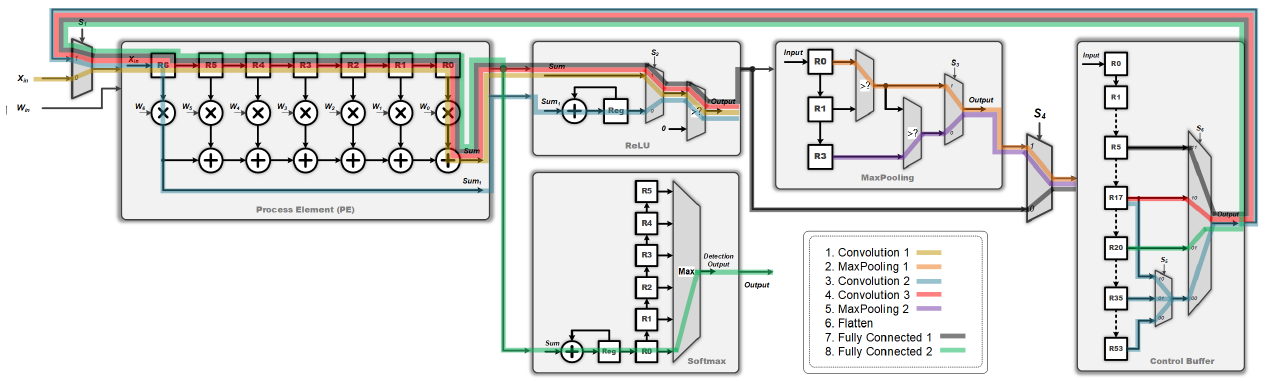
Figure 8. The operation for each layer in the proposed